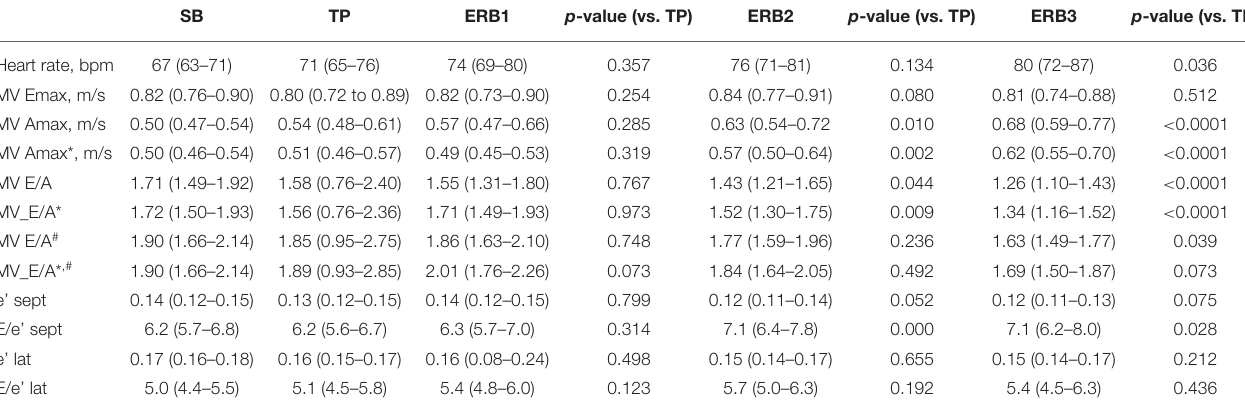
TABLE 2 | Cardiovascular outcome measures during spontaneous breathing (SB), tachypnea (TP) and expiratory resistance breathing with diameters of 3mm (ERB1), 2mm (ERB2), and 1.5mm (ERB3). SB TP ERB1 p -value (vs. TP) ERB2 p -value (vs. TP) ERB3 p -value (vs.